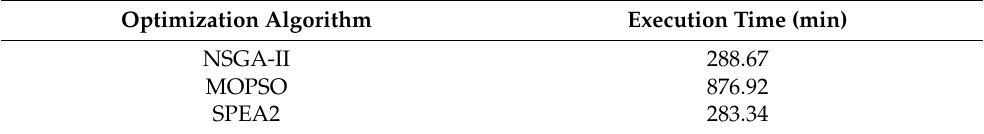
Table 10. Comparison of execution times.